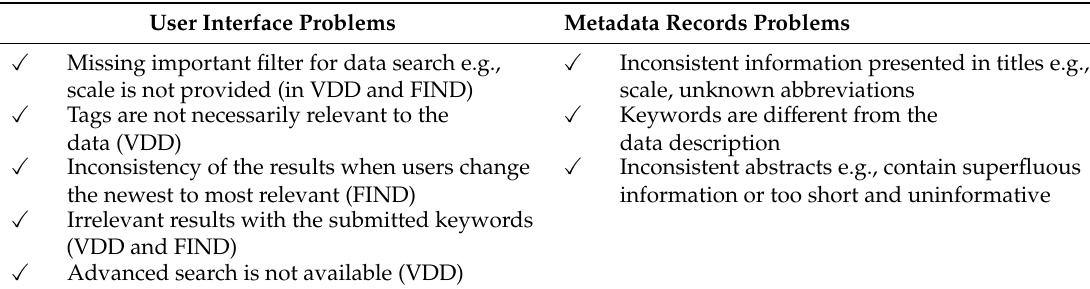
Table 6. Identified usability problems in spatial data discovery.